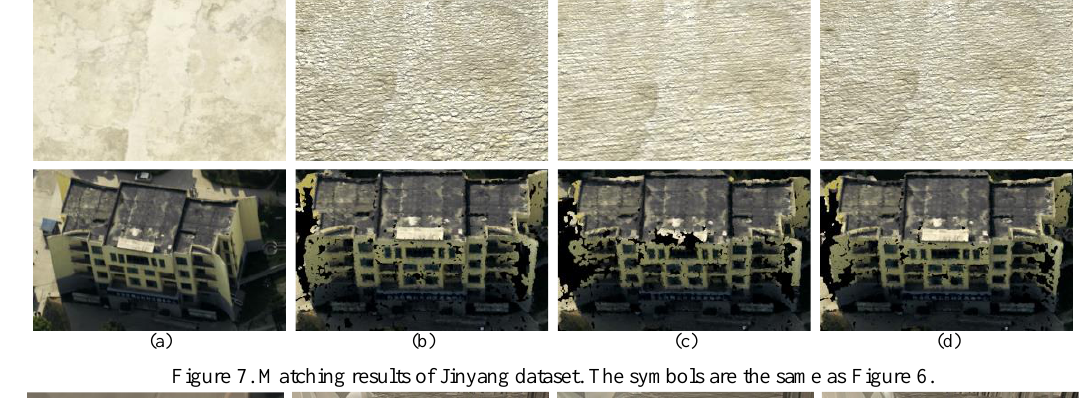
Figure 7. Matching results of Jinyang dataset. The symbols are the same as Figure 6.